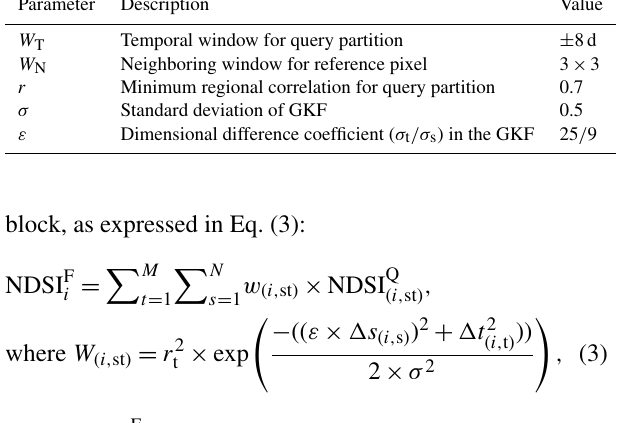
Table 2. Description and default values of STAF parameters. Parameter Description Value W T Temporal window for query